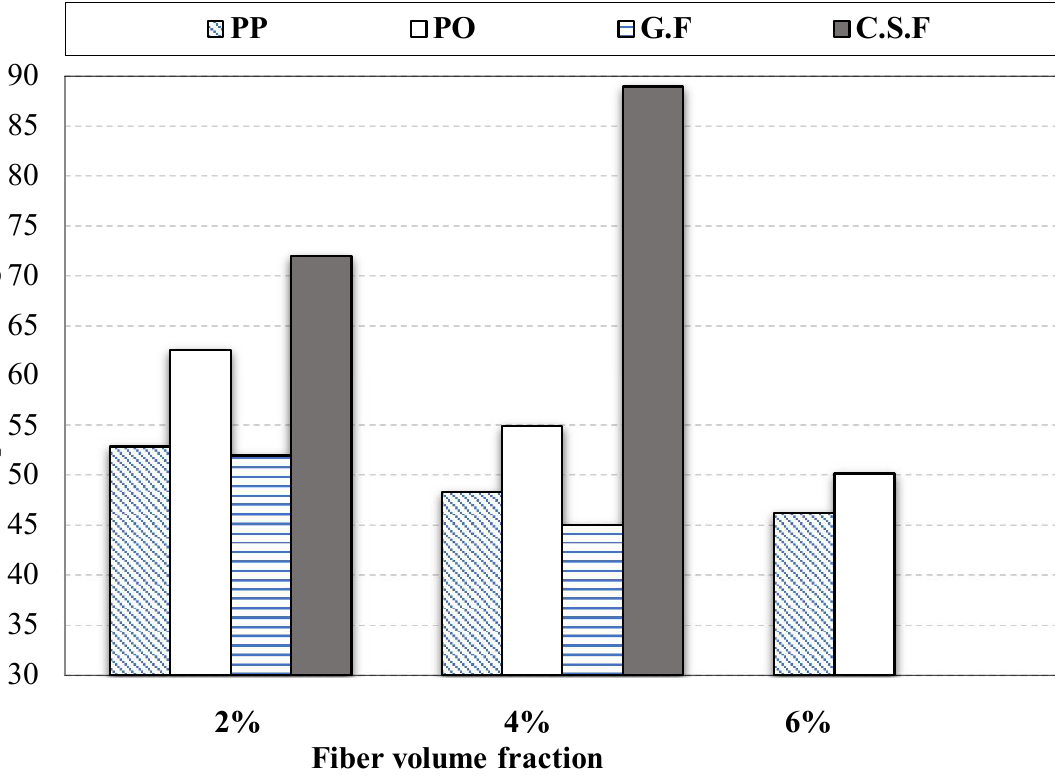
Figure 9. Compressive strength at 28 days due to fiber type change.